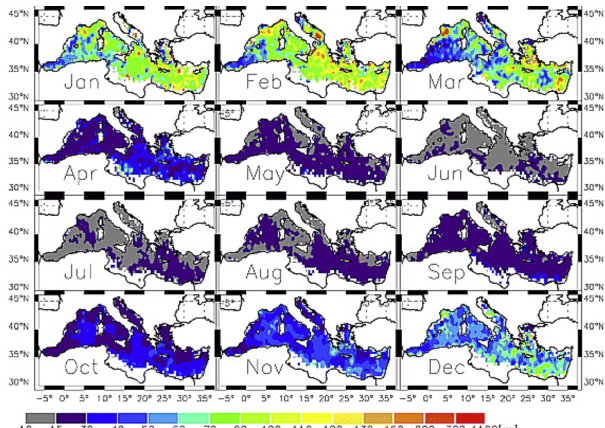
Figure 1. Mediterranean surface mixed-layer depth (m) monthly climatology over 1940–2004 (in meters; from D’Ortenzio et al., 2005; copyright 2005 by the American Geophysical